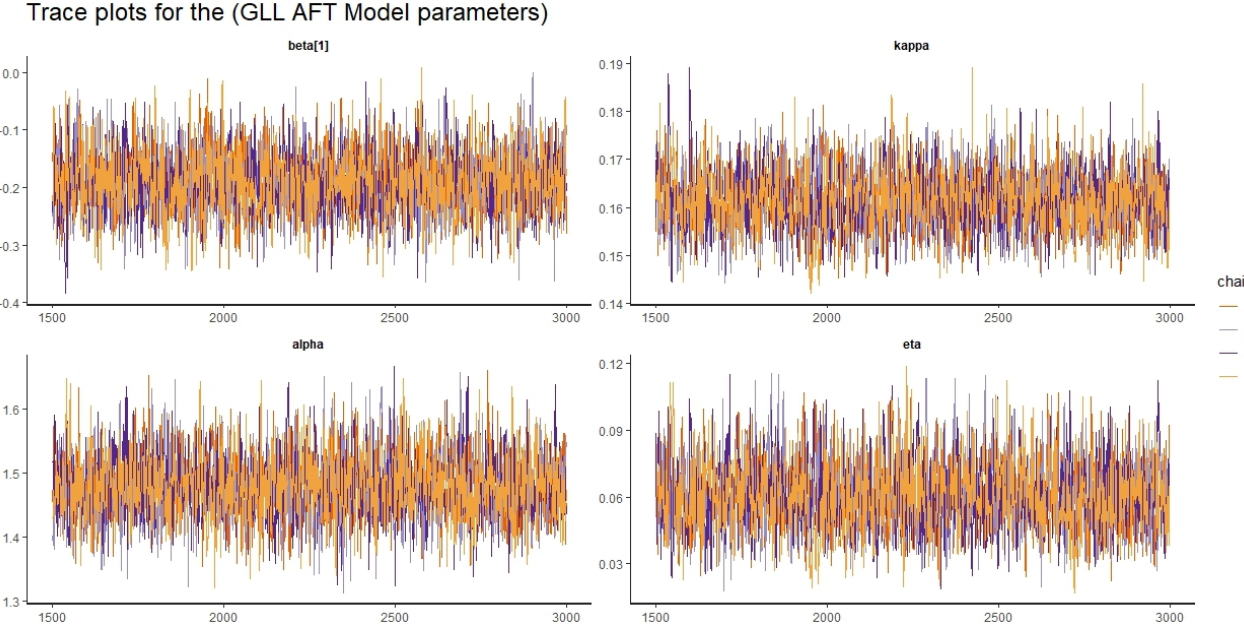
Figure 13. Trace plots for the GLL − AFT model